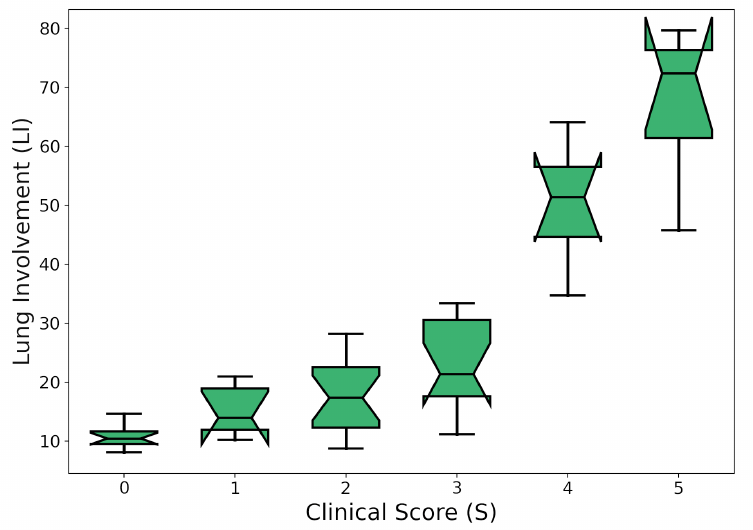
Figure 5. Box plot of S vs. lung involvement ( LI ). For each S, the median ± quartiles and min–max of LI are